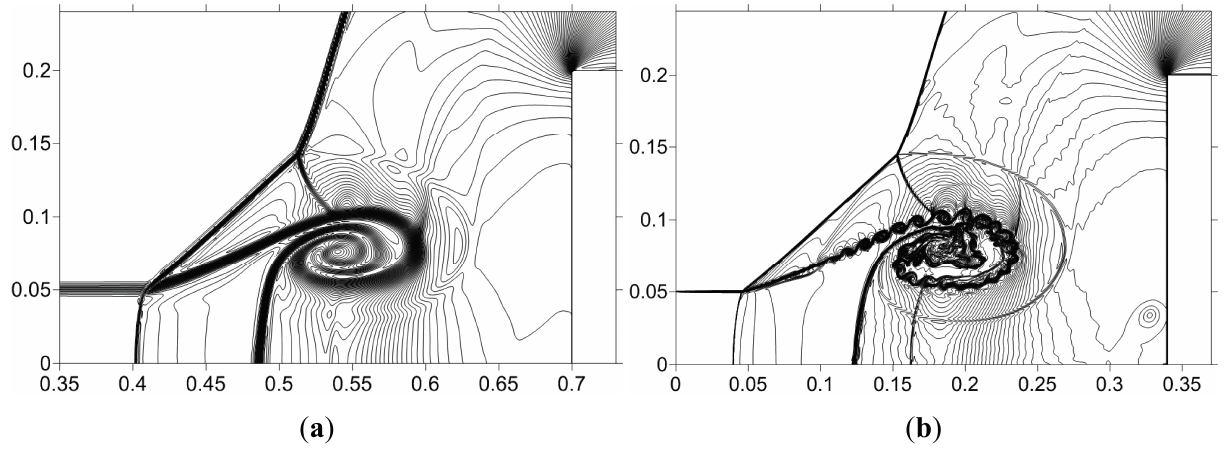
Figure 14. Density contours, α ρ = 0.4: ( a ) Fine grid I; ( b ) Fine grid